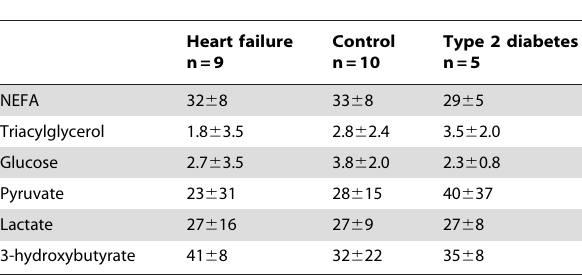
Values are mean 6 SD.